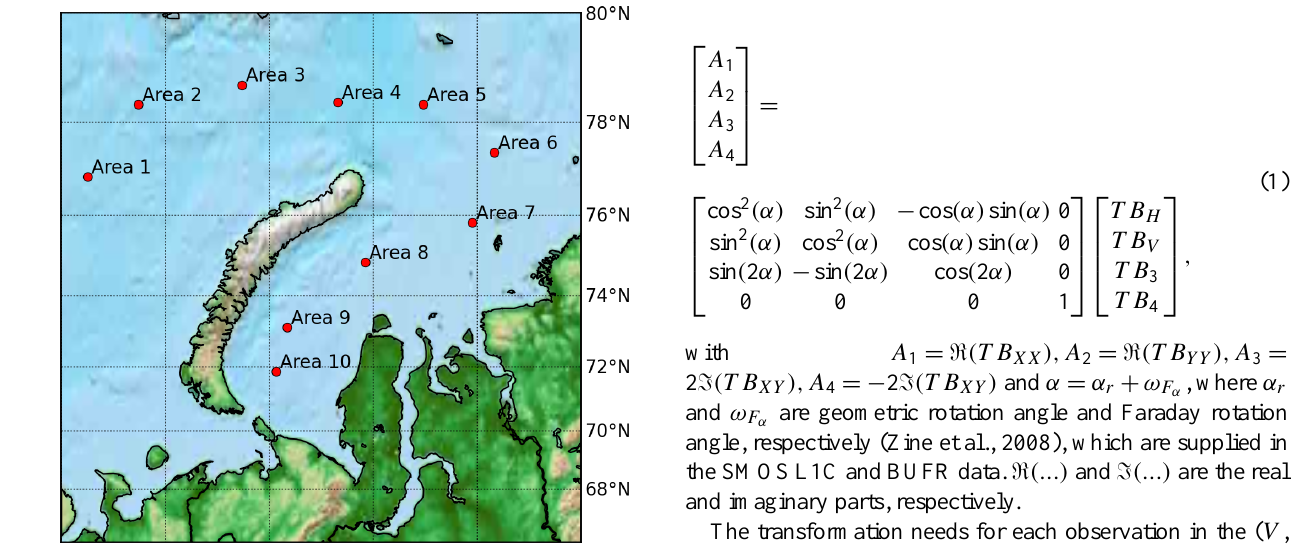
50 km × 31 km. As each footprint overlaps several grid points (Castro, 2008), the data of neighbouring grid points are cor-